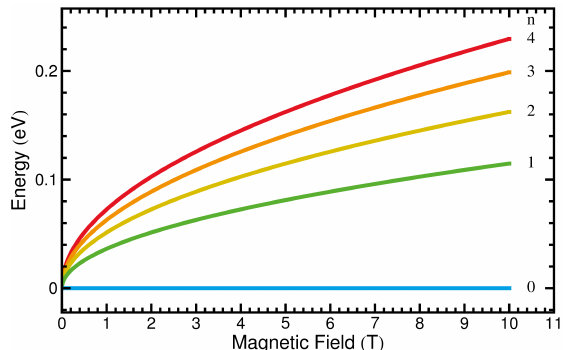
Figure 2: Landau level spectrum. The electronic dispersion of graphene under a homogeneous magnetic field (Eq. (12) ) is shown in dependence of the magnetic field component perpendicular to the graphene